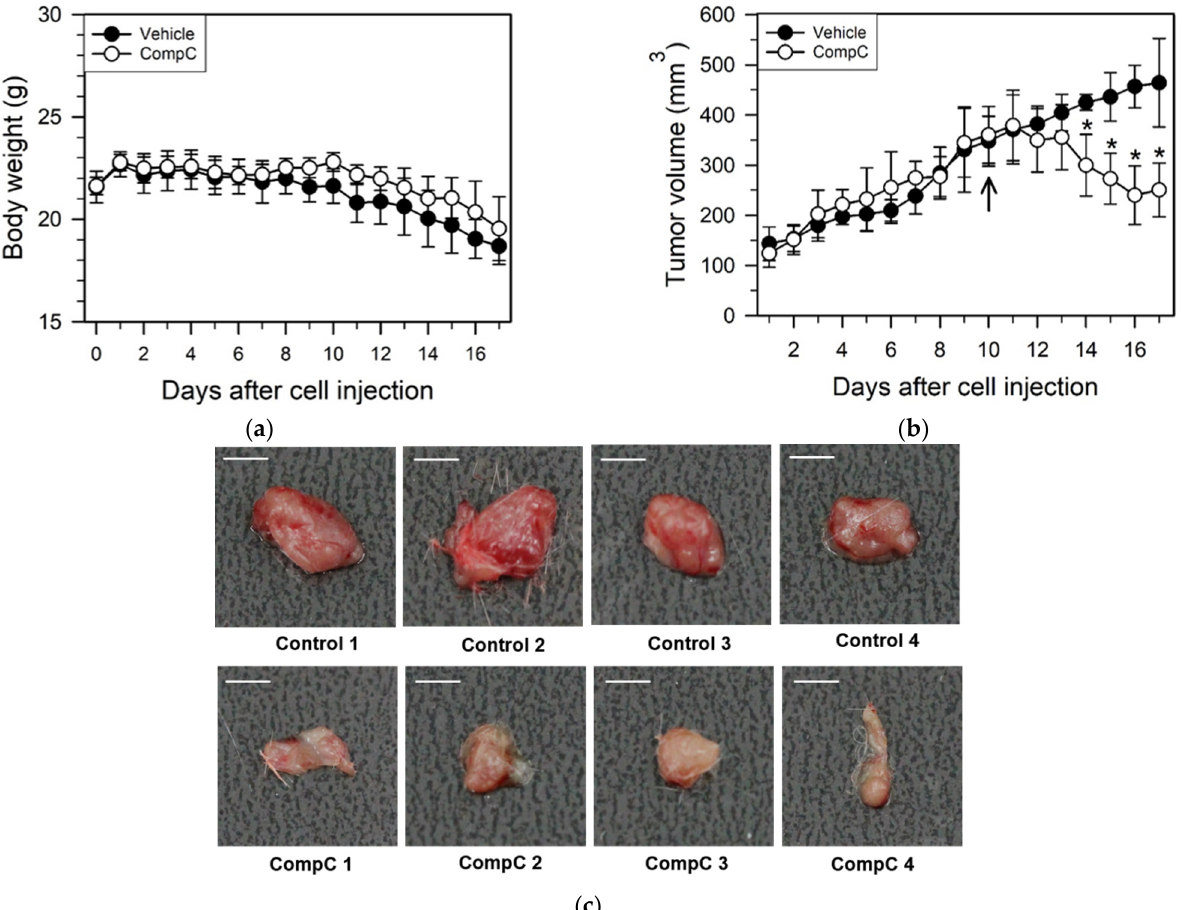
Figure 8. CompC inhibited the growth of Renca xenografts in BALB/c syngeneic mice. Ten days after the subcutaneous injection of Renca cells (arrow), vehicle or CompC (2.5 mg/kg/day) was intraperitoneally injected to the tumor-bearing BALB/c mice. During the experimental period, the body weight and tumor volume were recorded every day. The Kruskal–Wallis H test followed by a Bonferroni-corrected Mann–Whitney U test were used as a post-hoc comparison of the daily tumor volume in the mouse model. Significant difference in the tumor volume between vehicle and CompC injection groups at each day is marked with an asterisk. The means and SD are plotted (n = 5 for biological replicates at each time points in ( a , b )). * p < 0.01, compared with the vehicle-injected control mice. Seven days after daily vehicle/CompC injection, the animals were euthanized, and tumors were excised and photographed ( c ).